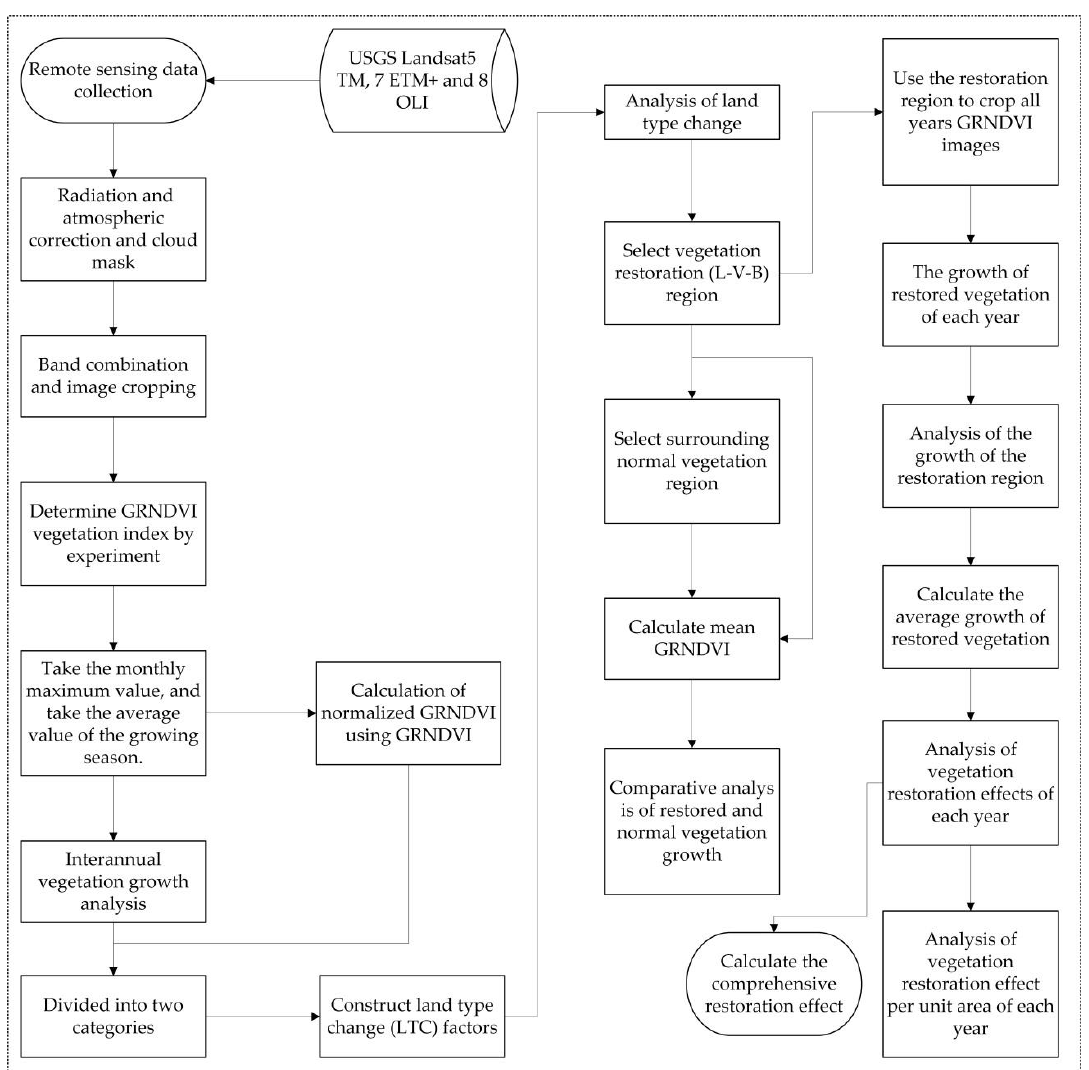
Figure 2. Main workflow of the proposed method.